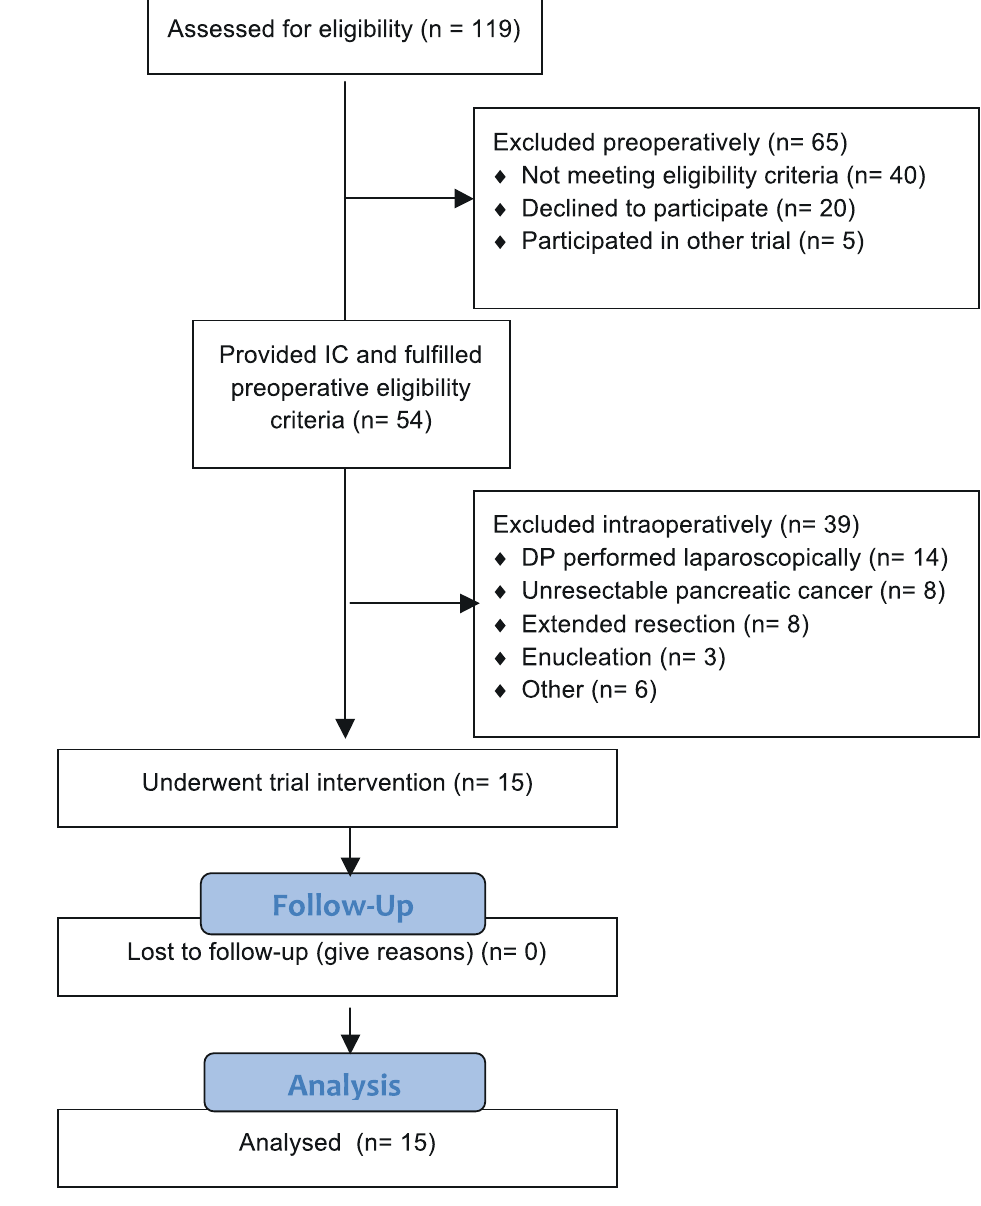
Fig 1. Study flow chart displaying the selection of the study cohort. https://doi.org/10.1371/journal.pone.0205748.g001 PLOS ONE | https://doi.org/10.1371/journal.pone.0205748 October 16,